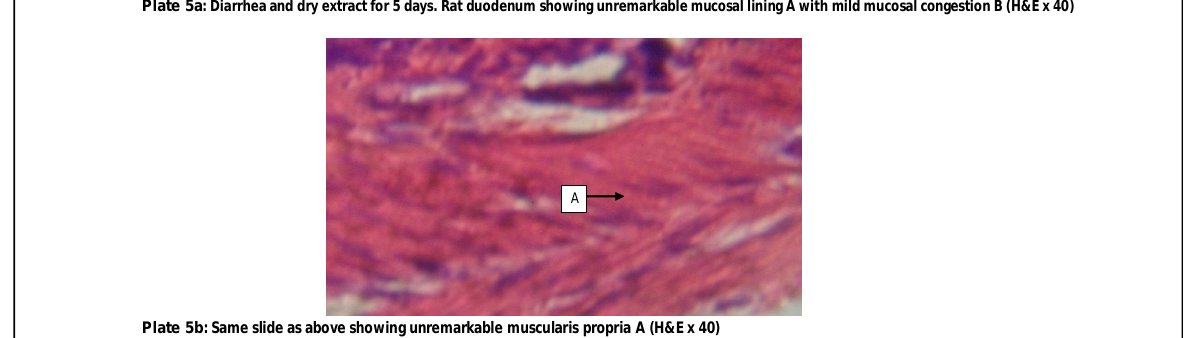
Plate 5b :Same slide as above showing unremarkable muscularis propria A (H&Ex 40)